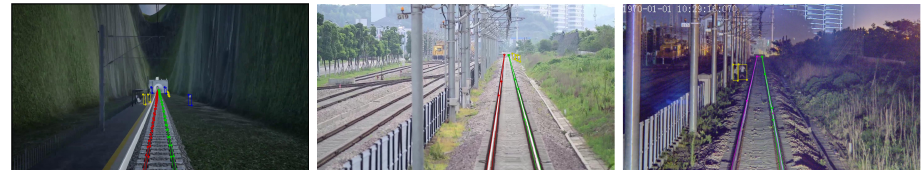
Figure 6. The annotation results of data we used. The red area represents the left track line, and the green area represents the right track line. Two track lines are used to perform track line identification. The yellow part represents people, and the blue part represents signal lights. These obstacles are used to perform object